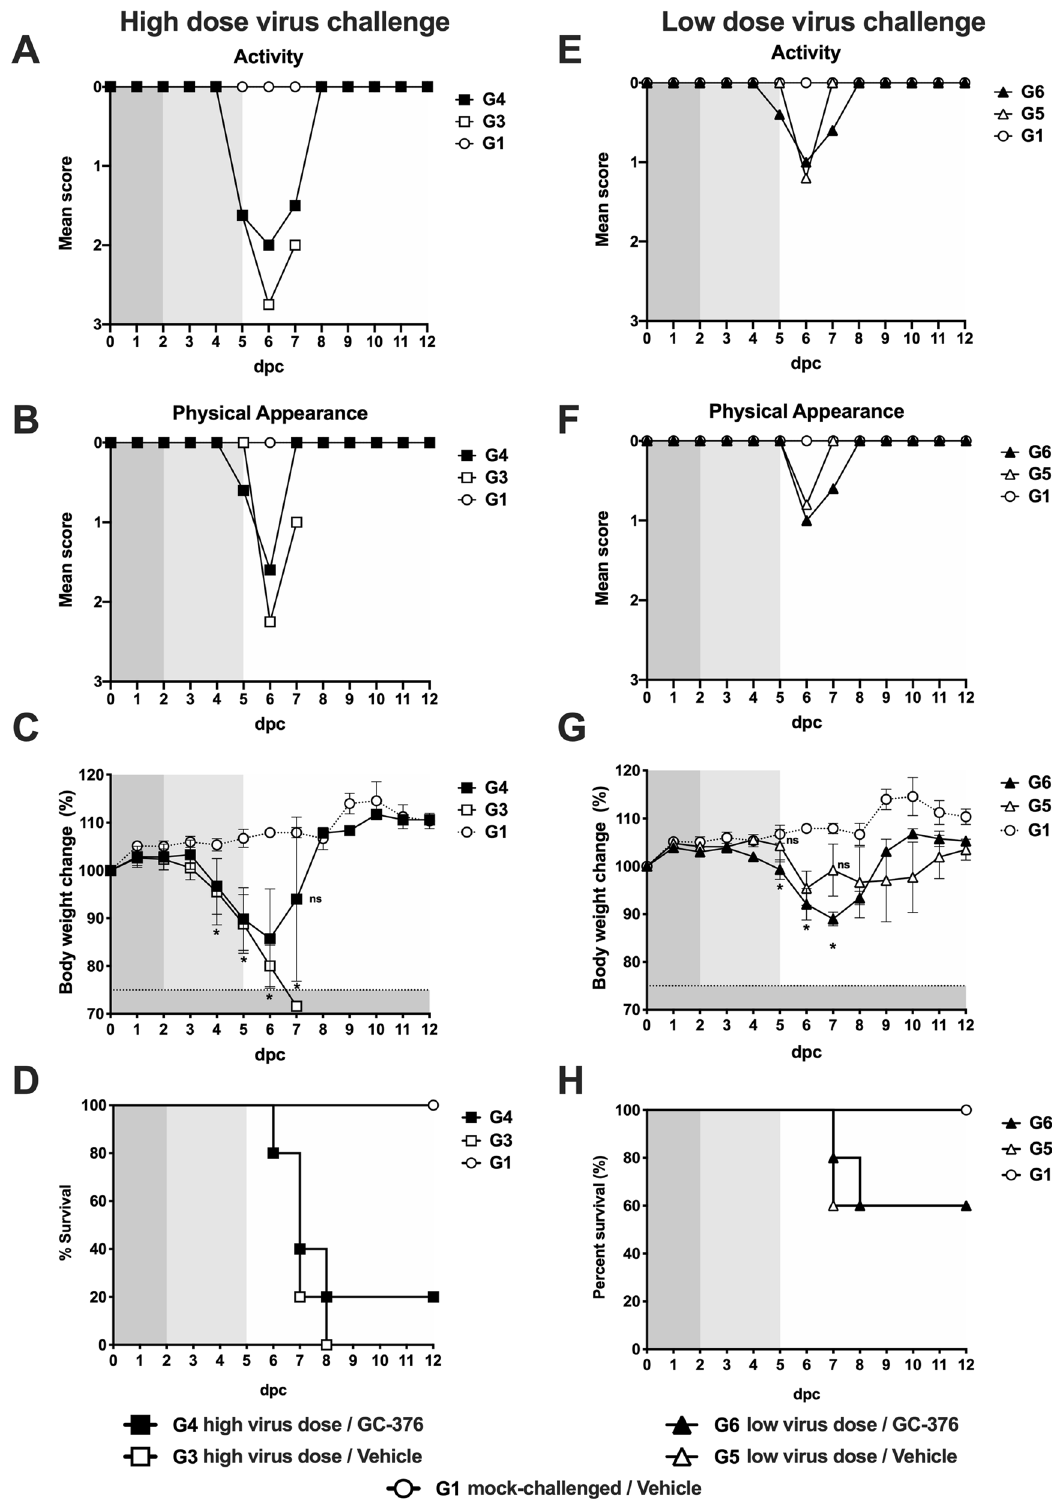
Figure 2. Efficacy of GC-376 in terms of clinical signs and survival after challenge with SARS-CoV-2. Mice (n = 11/group) were challenged with a ( A – D ) high dose (1 × 10 5 TCID50/mouse) or ( E – H ) low dose (1 × 10 3 TCID50/mouse) of SARS-CoV-2 and treated with drug vehicle (white symbols) or 40 mg/kg of GC-376 split in two doses per day for 7 days (black symbols). ( A , E ) activity, ( B , F ) physical appearance, ( C – G ) weight change and ( D , H ) survival (n = 5). Statistical analysis was performed by a two-way ANOVA, *p < 0.05. Grey shading represents remaining number of animals at time of clinical evaluation (n = 11; dark grey, n = 8; mid grey, n = 5 light